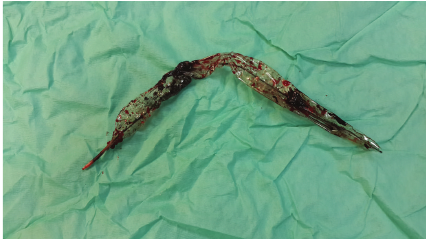
Figure 2: Firm thrombus inside the